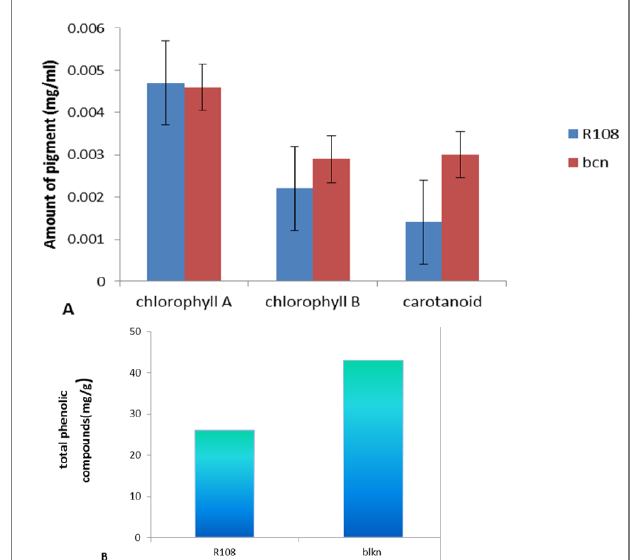
Figure 4 . (A) measurement of pigment contents in R108 and blkn showing no significant difference in both types of chlorophylls (A and B) between R108 and blkn at ( p =0.7) for chlorophyll A and at ( p =0.06) for chlorophyll . While blkn produces more than douple amounts of carotenoids than R108 with a significanc differenc at ( p =0.02) . (B) blkn roots contain more than double content of phenolic compounds than R108 ( p